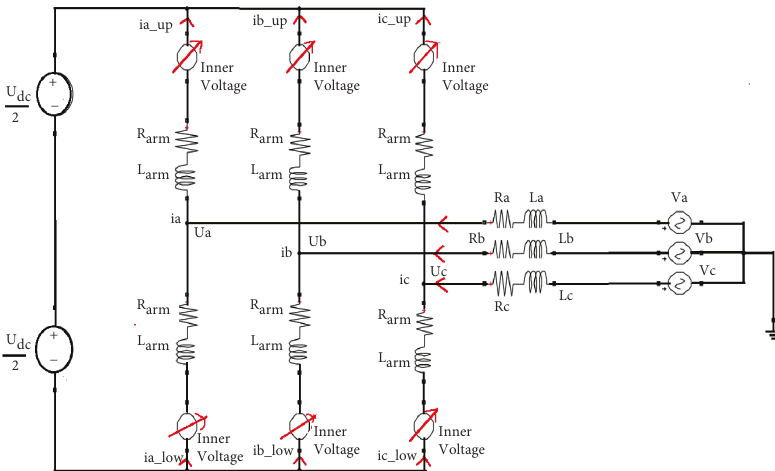
Figure 3: Equivalent circuit of the